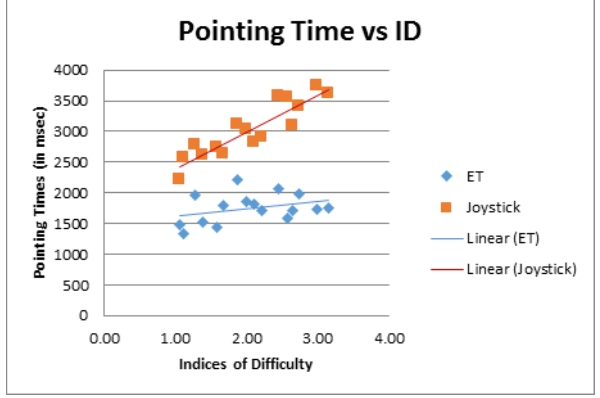
Figure 22. Comparing Pointing and Selection Times w.r.t. ID.